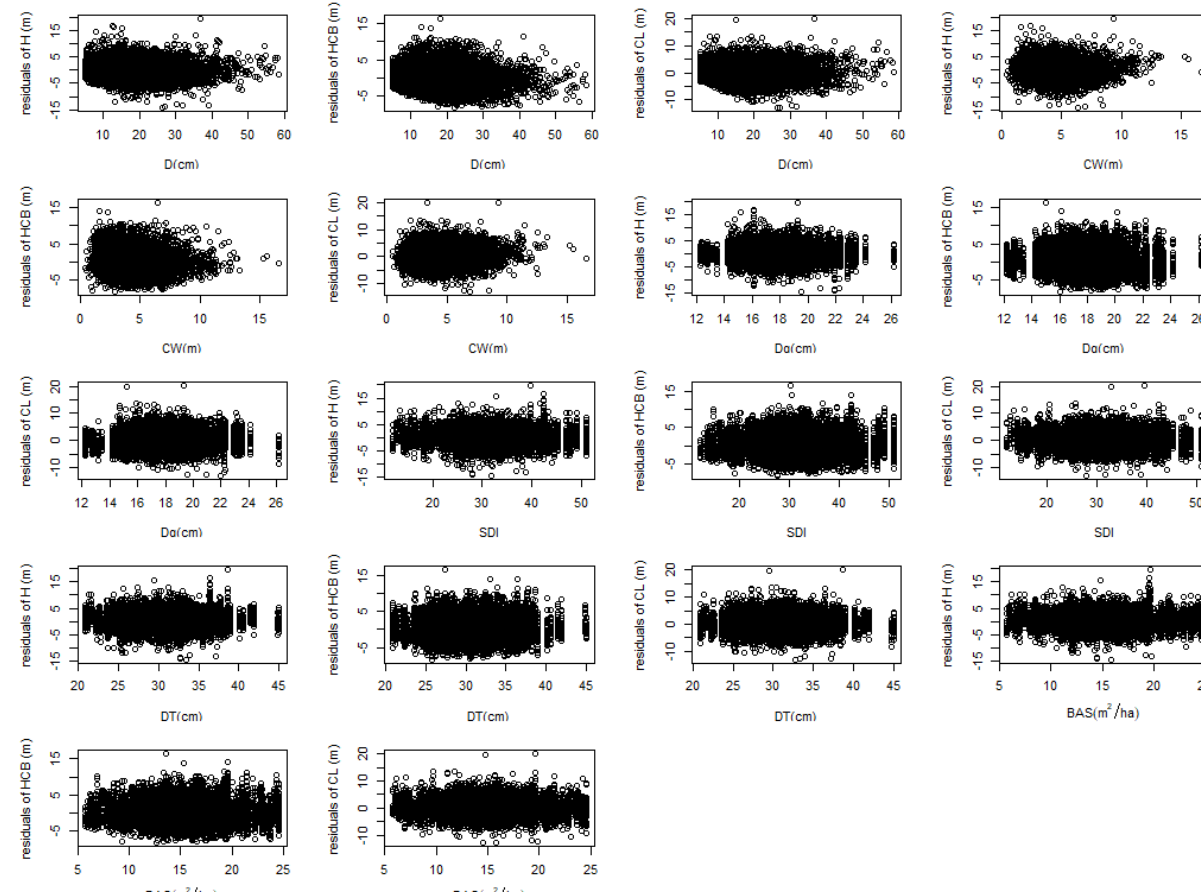
Figure 5. Residuals against predictors of Equation (20) ( D : diameter at breast height (cm); CW : crown